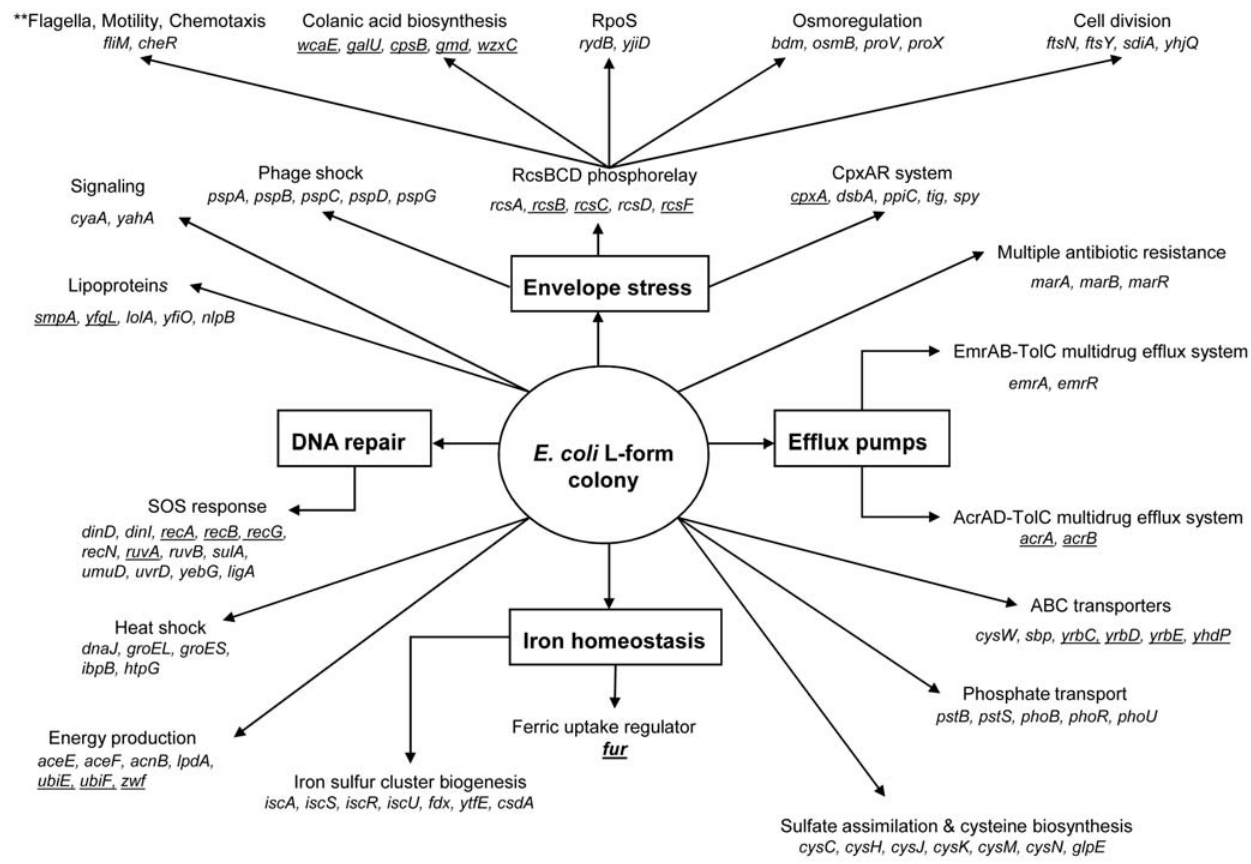
Figure 5. Proposed pathways involved in L-form formation and survival in E.coli . Pathways, which are bold and framed, were enriched among Group 1 mutants that failed to form L-form colonies, were overexpressed in our microarray analysis, and were among complemented mutants (except drug efflux pumps). Representative overexpressed genes in the microarray results from different pathways are presented under each pathway. Underlined genes correspond to those that were identified in our mutant screen analysis. Bold underline genes were only present in the mutant screen. ***Represents down-regulated pathway.